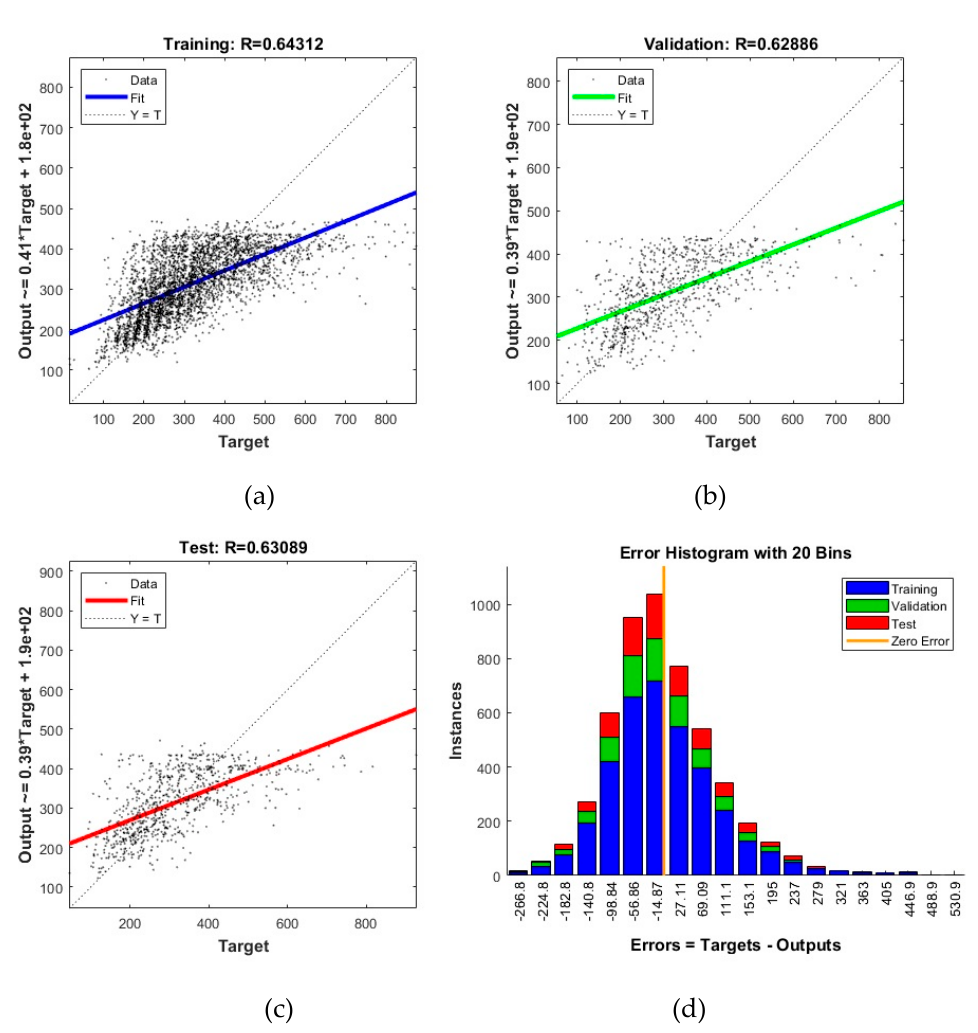
Figure 14. Training result of Network 4: (a) regression result from training data; (b) regression result from validation data; (c) regression result from test data; (d) histogram of the distribution of absolute errors.